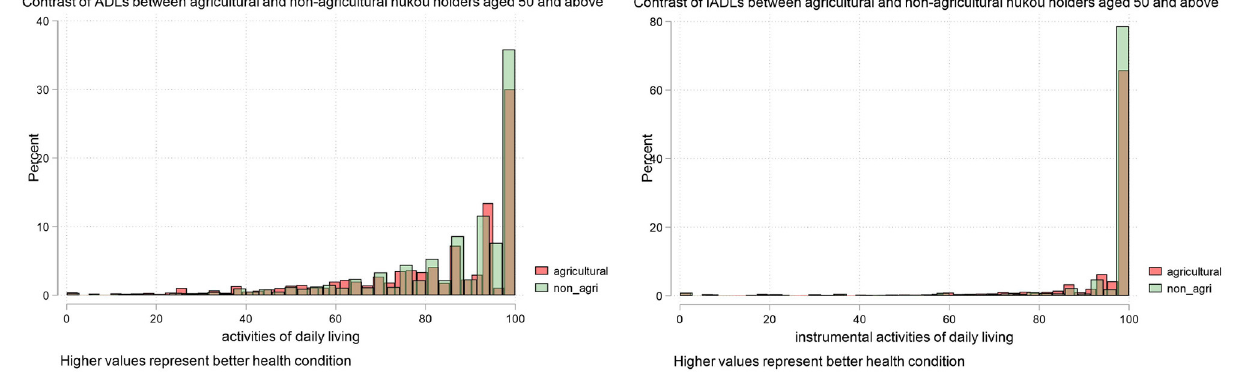
statistics of variables satisfying our sample restriction